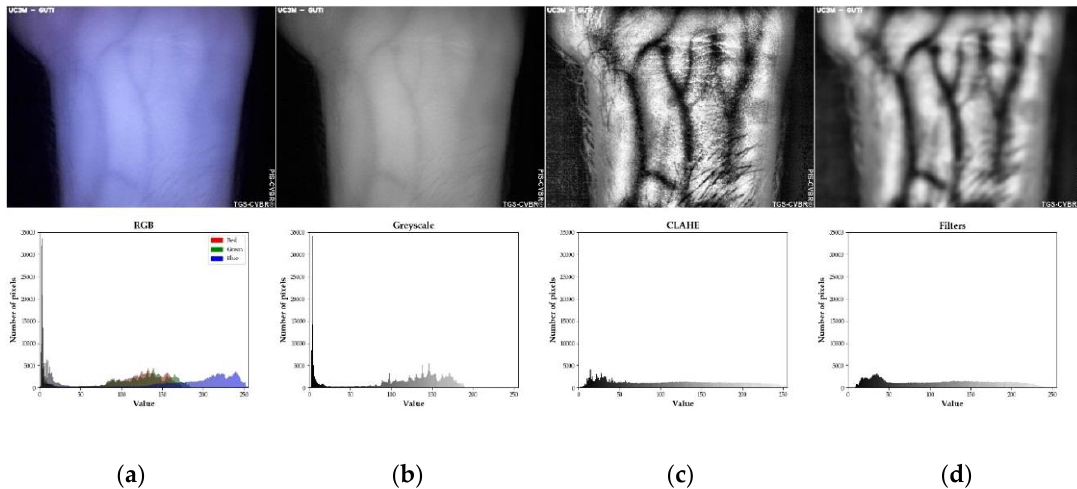
Figure 3. Preprocessing and Identification Software for Contactless Vascular Biometric Recognition (PIS-CVBR ® ): Preprocessing steps for User 0. Example images (above) and their histograms (below): ( a ) RGB image. ( b ) Image after greyscale conversion. ( c ) Image after greyscale conversion and Contrast Limited Adaptive Histogram Equalization (CLAHE) algorithm. ( d ) Image after greyscale conversion, CLAHE algorithm, and filtered by Gaussian filter, Median filter, and Averaging (11 × 11 kernel).